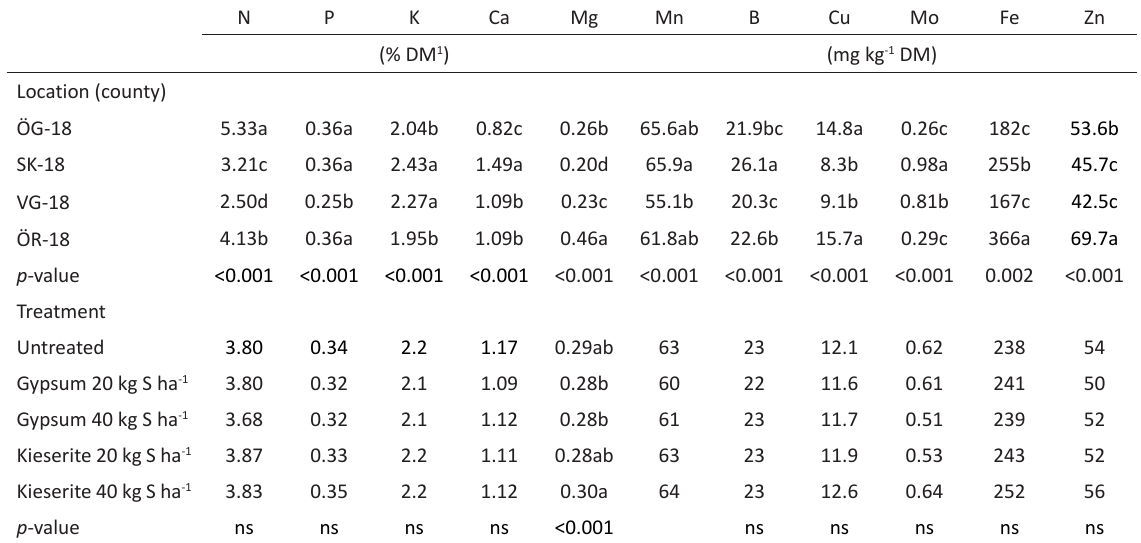
Table 5. Concentrations of macronutrients and micronutrients in faba bean at the beginning of flowering (BBCH 60) at the four field experiment locations in 2018 with various sulphur treatments